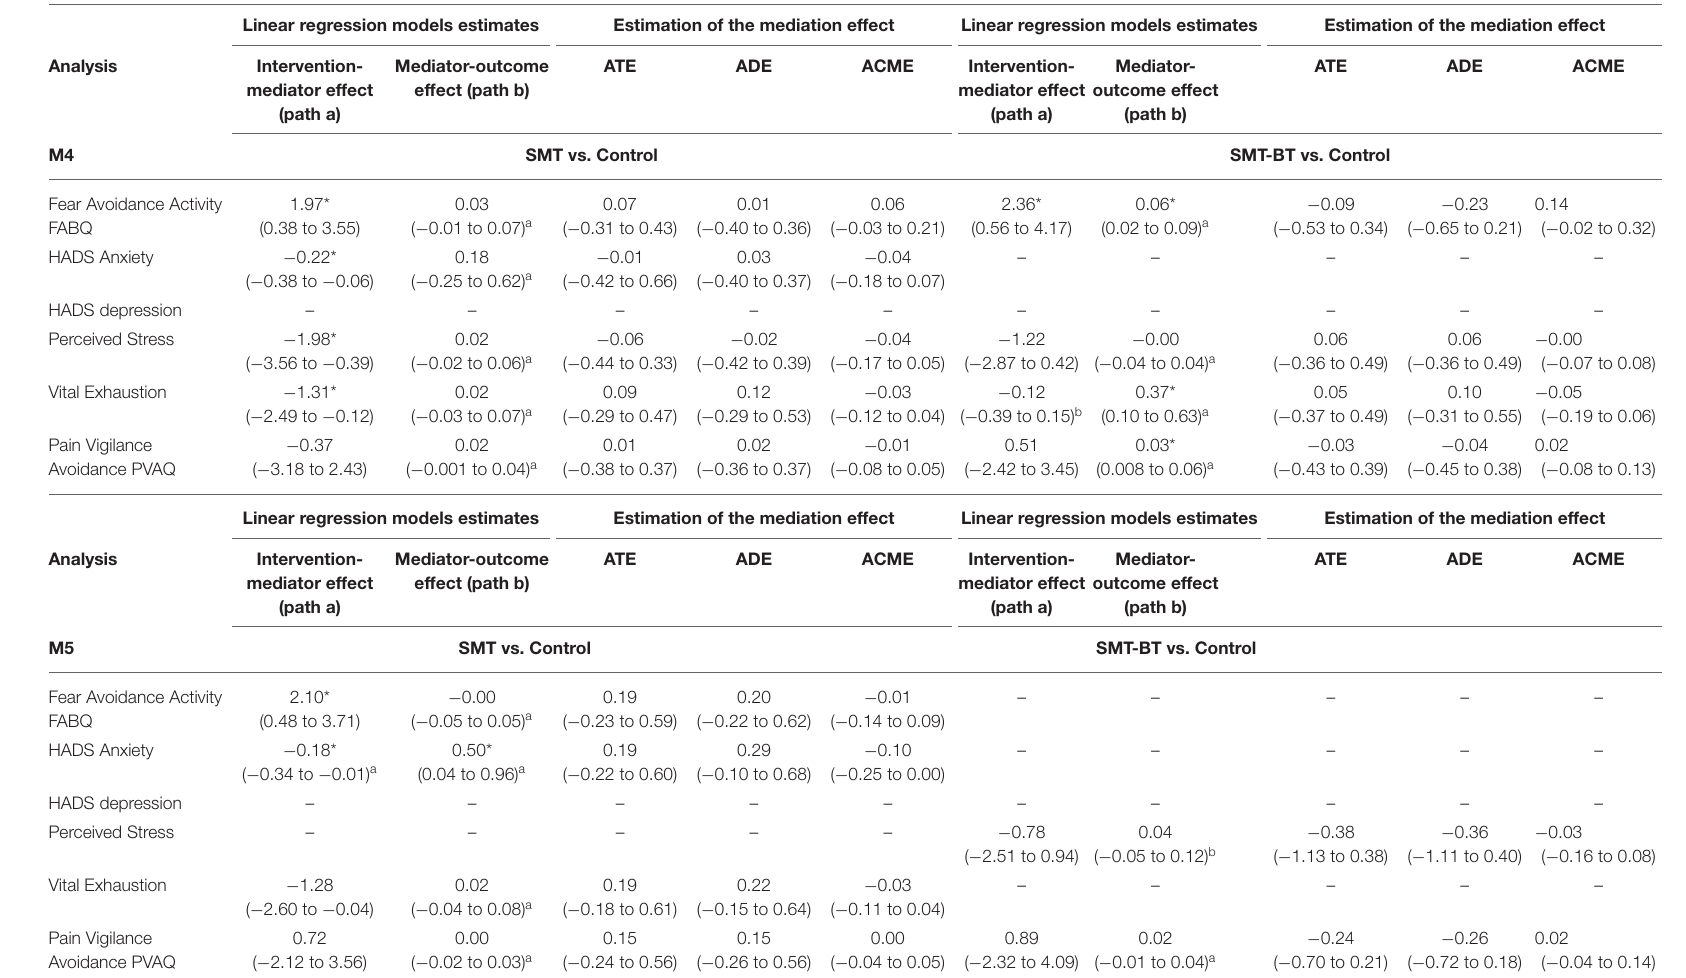
TABLE 4 | Effect decomposition for each single-mediator